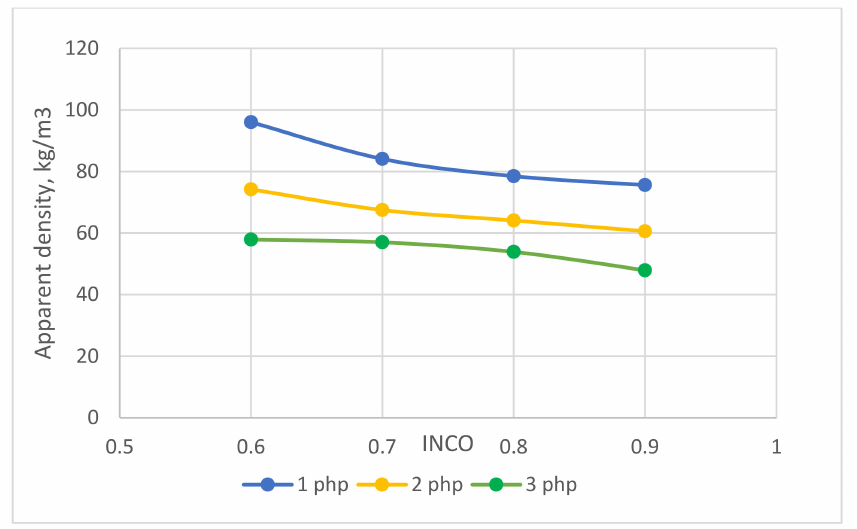
Figure 2. The apparent density of manufactured foams depending on the isocyanate index and water